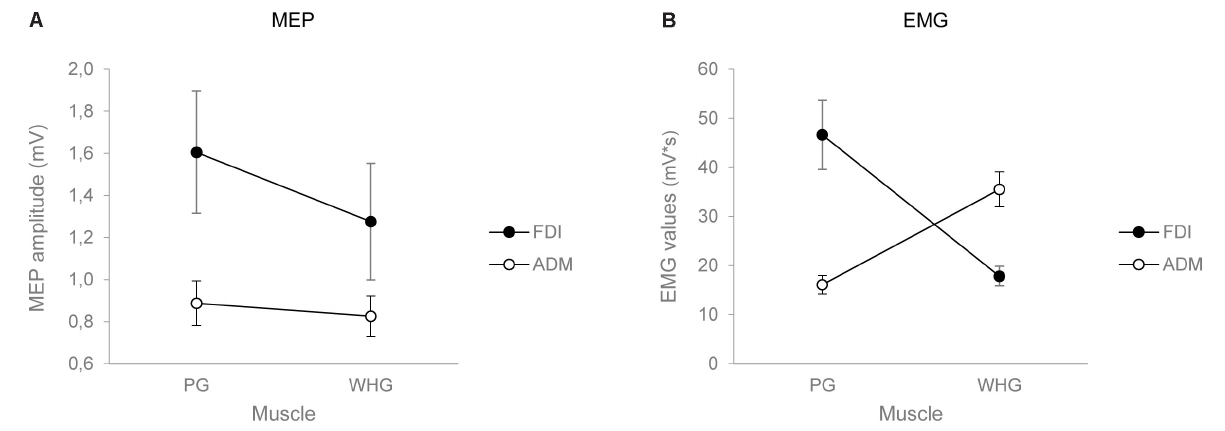
Frontiers in Psychology |